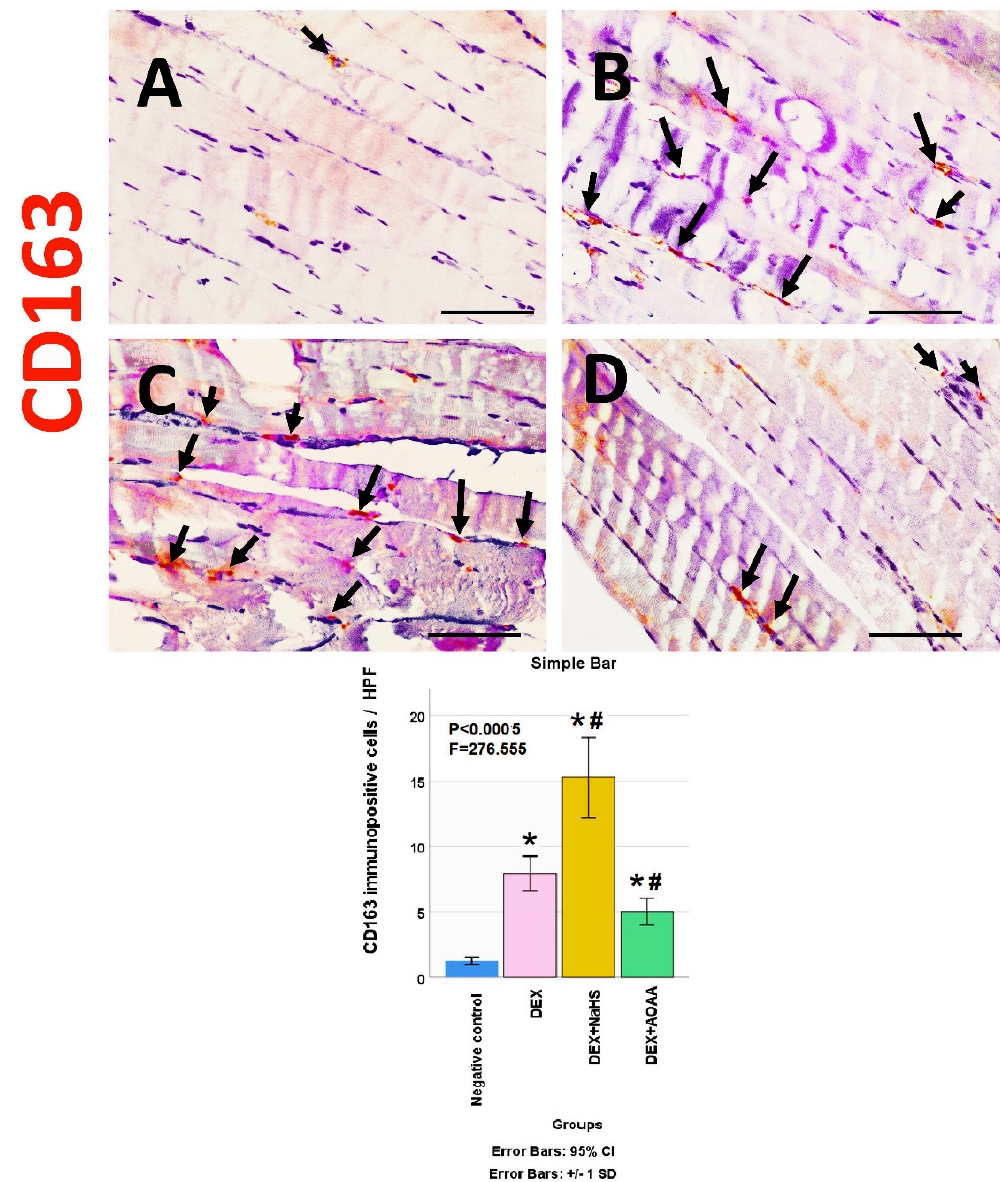
Figure 8. ( A – D ): Light-microscopic image of CD163 immunostaining ( × 400) in soleus muscle tissues of all studied groups; Negative control, Dex, Dex + NaHS, and Dex + AOAA groups ( A – D ; respectively). Scale bar = 25 µ m. Arrows: CD163 immunopositive cells. (E) The mean of the number of CD163 immunopositive cells/HPF in the studied groups. Results are mentioned as mean ± standard deviation. The test used: one-way ANOVA, followed by post-hoc Tukey test. p : significance (<0.05). *: significance as compared to the negative control group. #: significance as compared